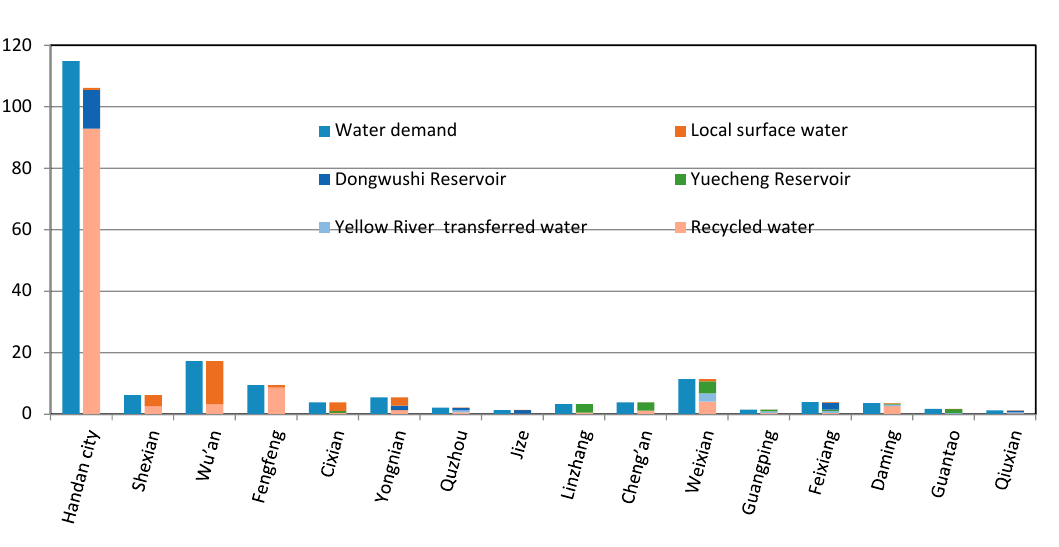
Table 5. Results for local surface water allocated to every user (10 6 m 3 ).